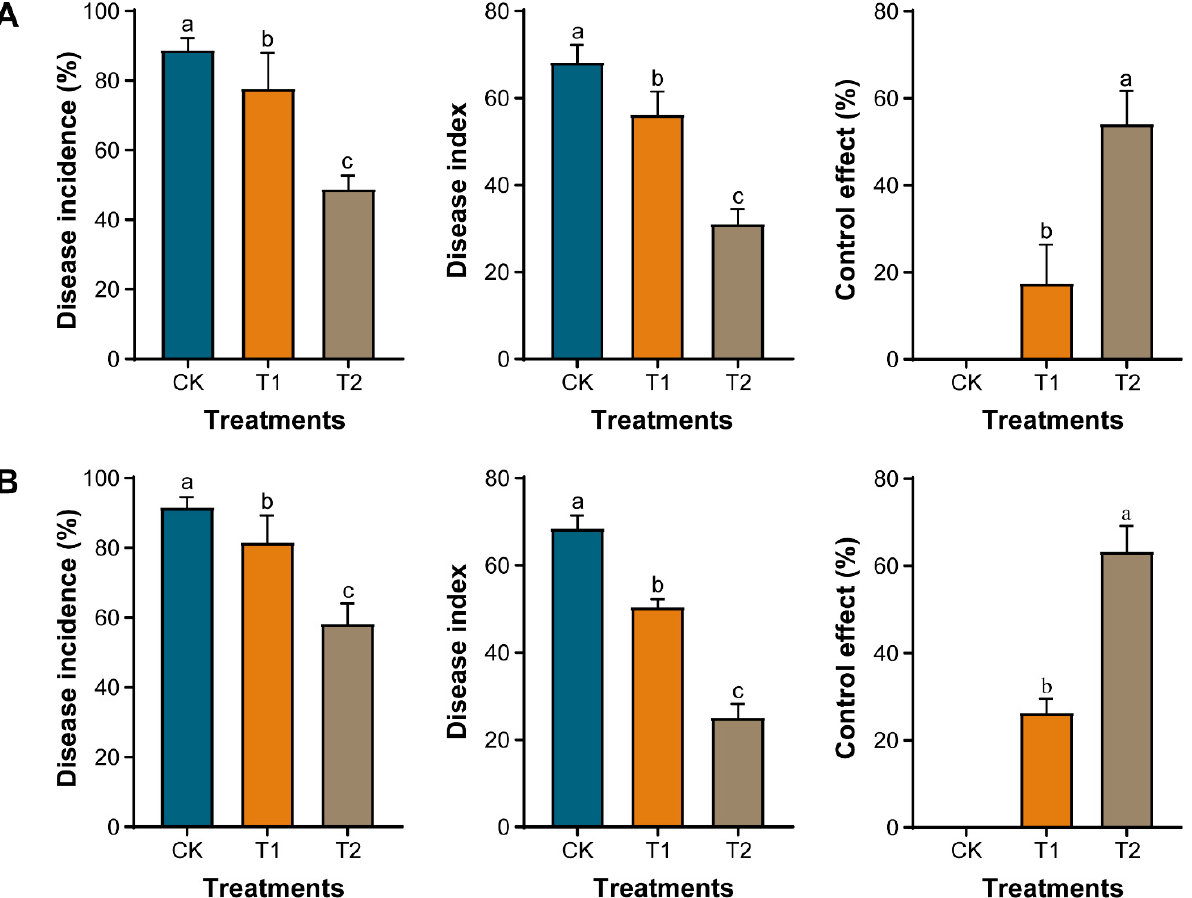
Figure 3. Effect of marigold crop rotation on the incidence of clubroot in Chinese cabbage under greenhouse and field conditions. Greenhouse ( A ) and field ( B ) conditions. Here, monocropping of Chinese cabbage (CK), Chinese cabbage seedlings were transplanted immediately after harvesting of the marigold crop (T1), and Chinese cabbage seedlings were transplanted with an empty period of 15 days after harvesting the marigold crop (T2). According to Duncan’s multiple range test ( p < 0.05), different small letters on the error bars represent a significant difference among treatments.